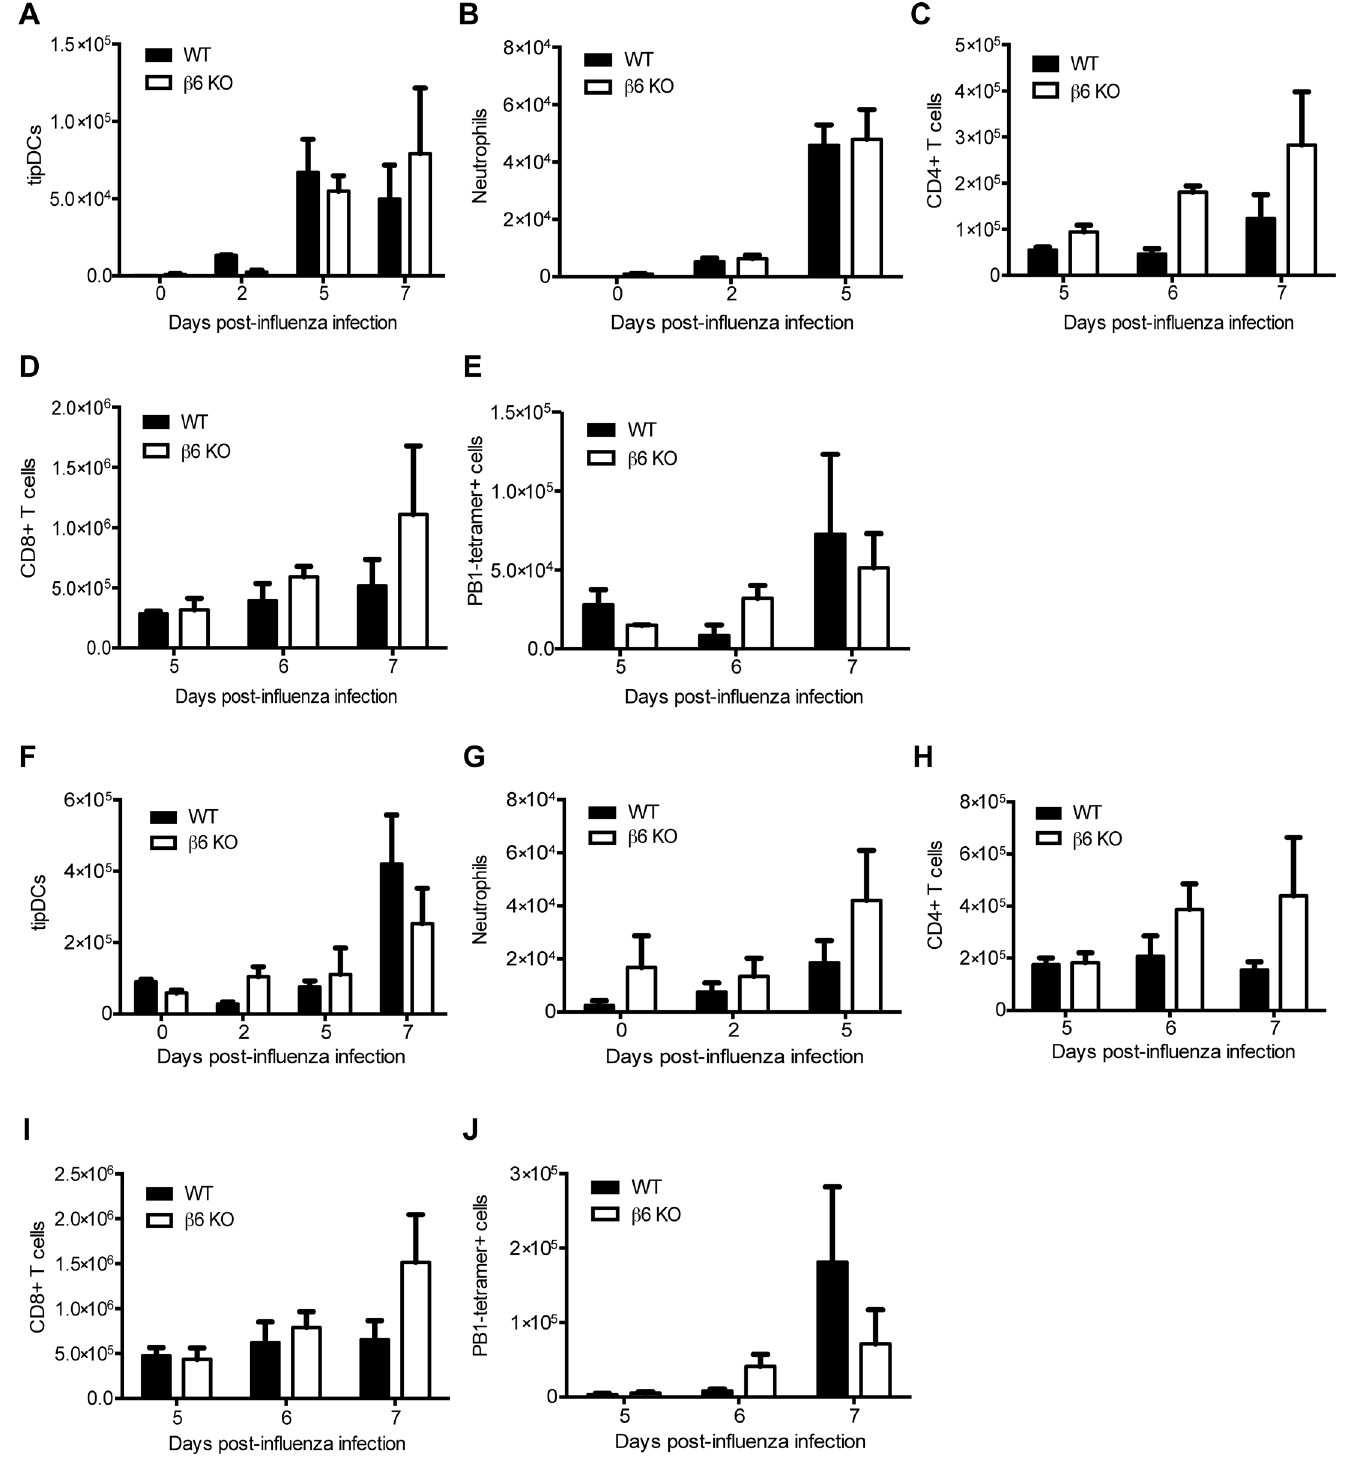
Fig 4. Immune cell populations in the BALF and lung. WT and β 6 KO mice were infected with influenza as described in Fig 1 and BALF (A – E) or whole lung (F – J) collected at the indicated times post-infection. Numbers of tipDCs (A, F), neutrophils (B, G), CD4 + T cells (C, H), CD8 + T cells (D, I), and PB1-tetramer + CD8 + T cells (E, J) were quantified. Data is pooled from 2 independent experiments, n = 3 – 5 mice per group. No significant differences were